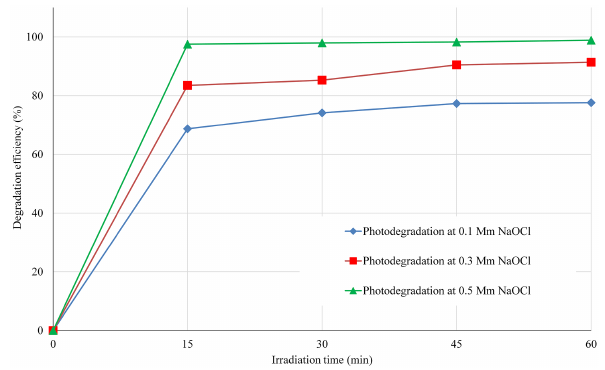
Figure 10. The concentration decrease of BPA using ZnO, TiO 2 and SnO 2 suspensions and advanced photooxidation (0.3mM